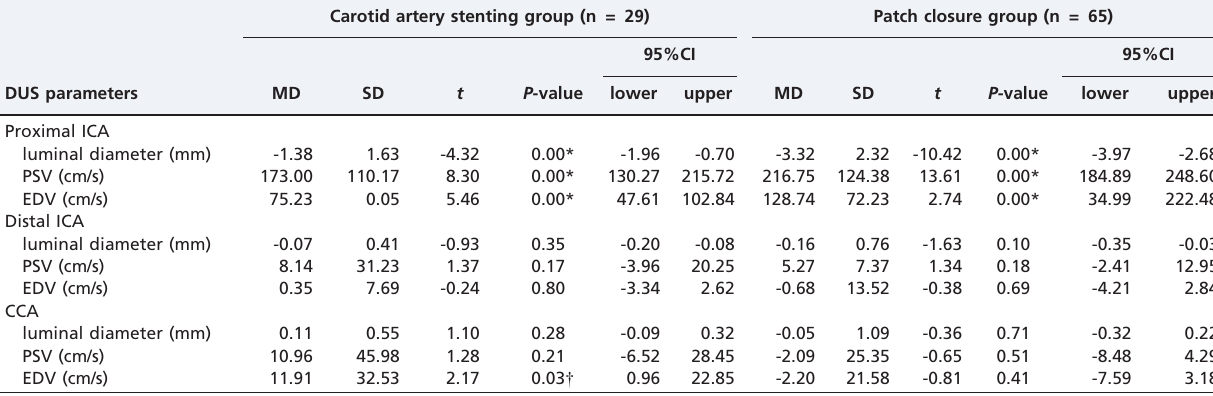
Table 2 – Short-term DUS results: Comparison of preoperative and 24h postoperative. Carotid artery stenting group (n = 29)